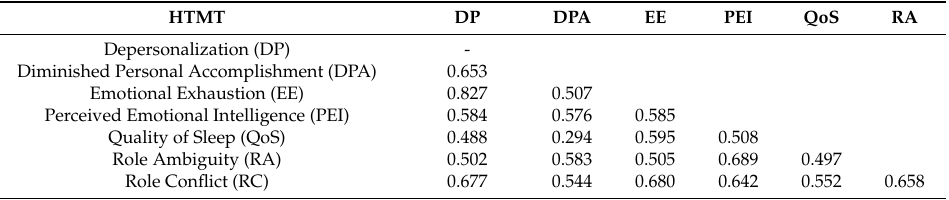
Table 4. Internal validity: heterotrait-monotrait (HTMT) for the total model. HTMT